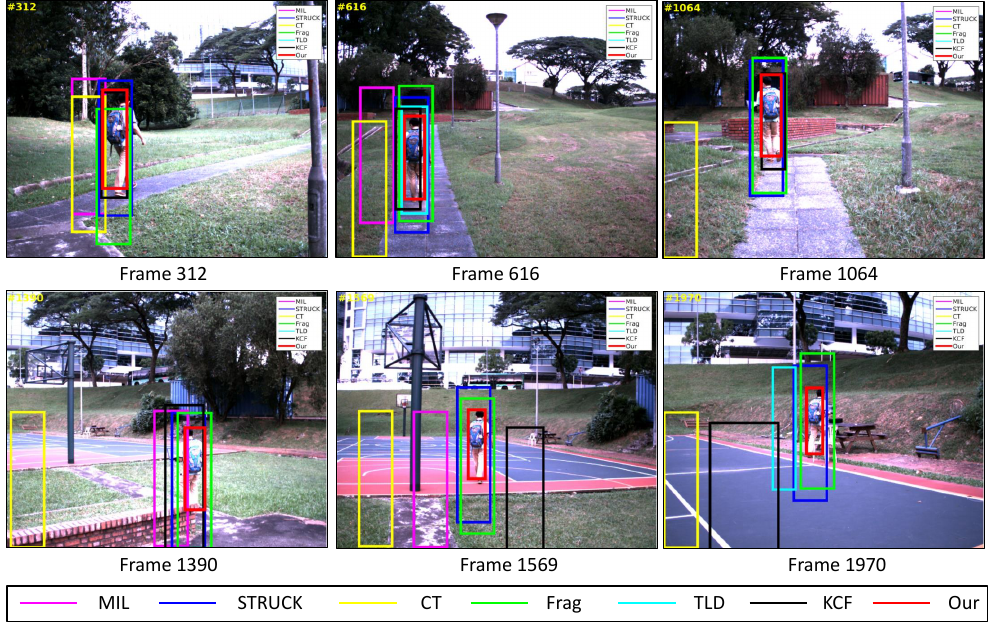
Figure 23. Some tracking results in the People fw image sequence. The total number of frame: